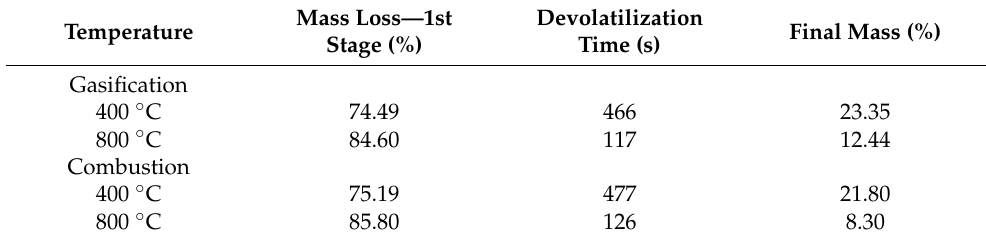
Table 2. Characteristic parameters of the mass loss curves at different regimes of thermochemical conversion in the same period of the experiment (600